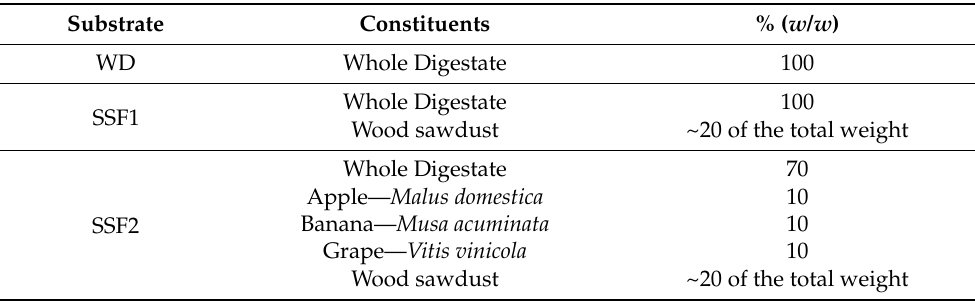
Table 2. Components of culture substrates for solid-state fermentation of Trichoderma